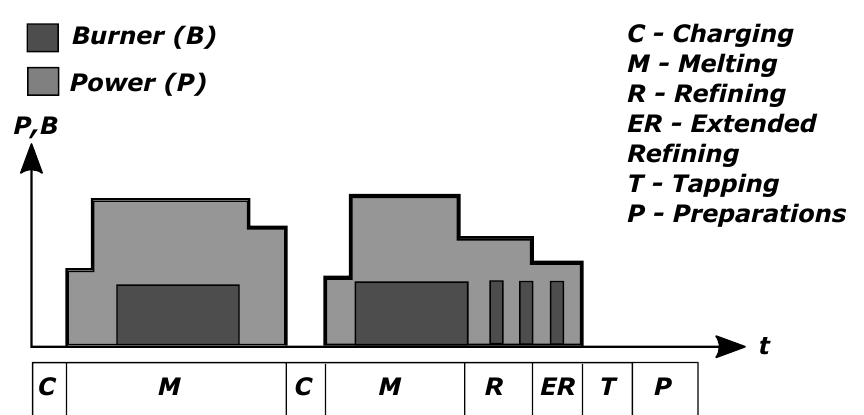
Figure 1. An idealized timeline over the EAF process for one heat. The Extended Refining is unique to the steel plant of study.